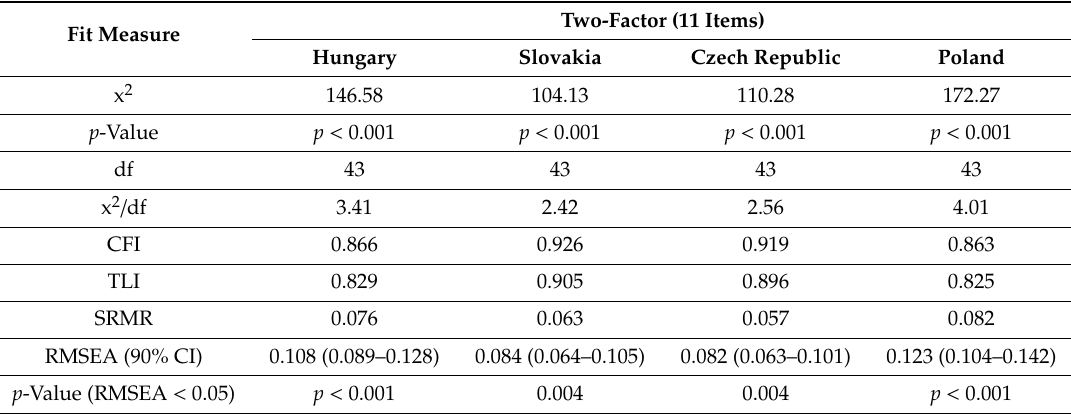
Table 4. Fit statistics for